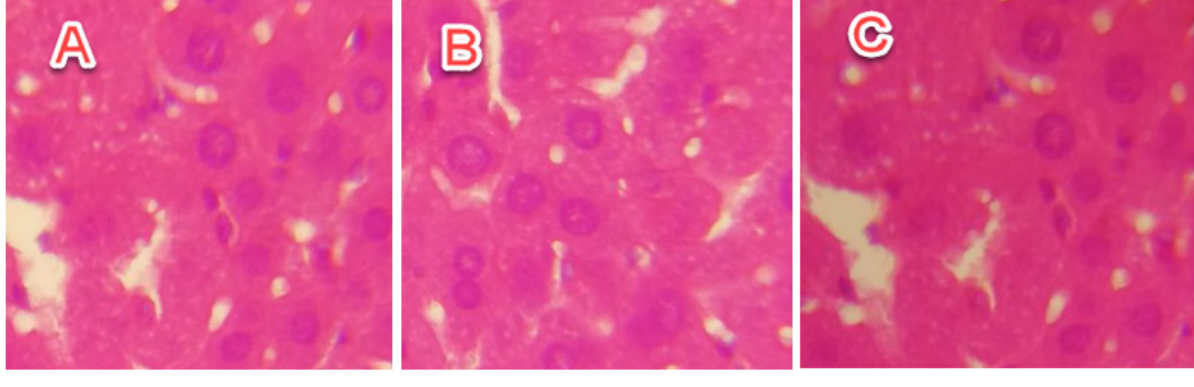
Figure 5 : The effect of the oral administration of aqueous extract of B. dioica roots on the kidney tissue of treated groups with doses up to the maximum of 250 mg/kg (Section stained with H&E, x 40) section of renal tissue of treated group with 62.5 mg/kg, (B) section of renal tissue of treated group with 125 mg/kg, (C) section of renal tissue of treated group with 250